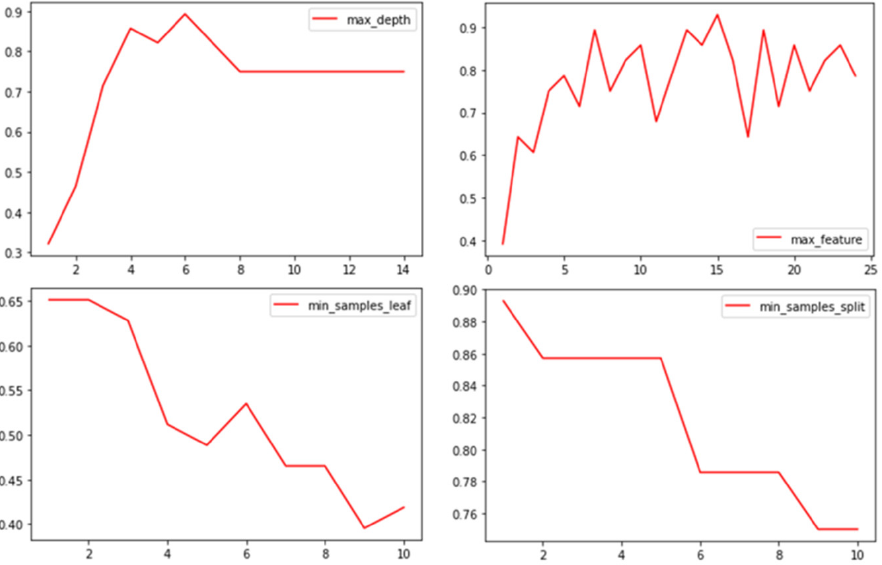
Figure 10. Parameter adjustments of the decision tree classification algorithm; the x-axis is the number of input feature factors, and the y-axis is the classification efficiency of the classifier after inputting feature factors.